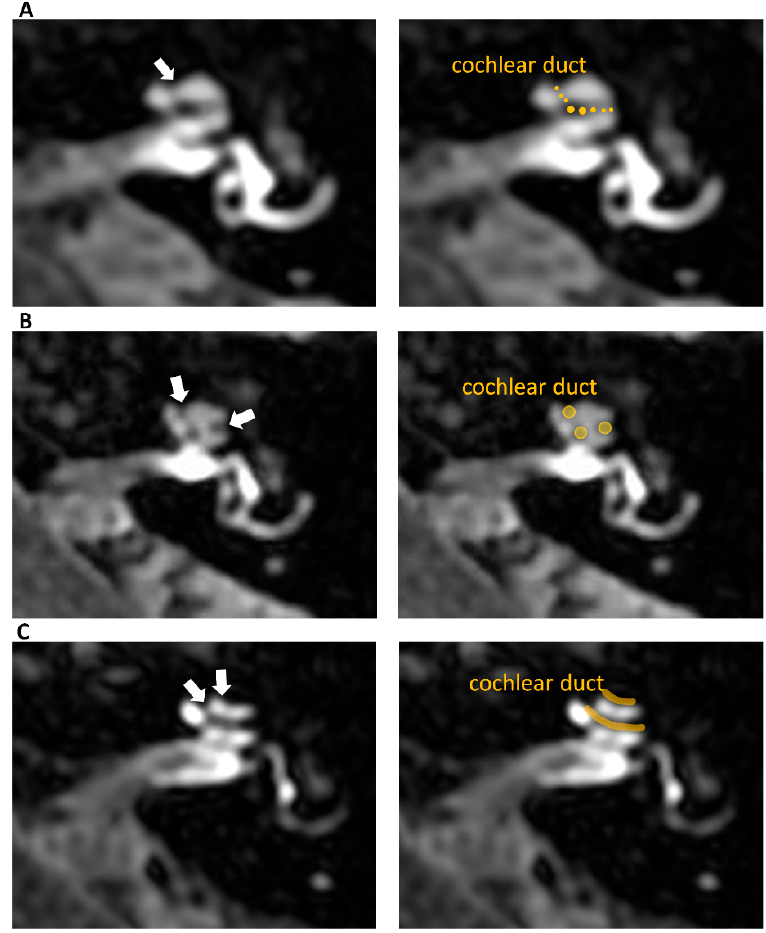
Figure 1. Delayed post-contrast 3D-FLAIR axial images of the left ears at the level of the cochlear modiolus. Right side images on panels ( A – C ) show the same images as the left ones in respective panels but in the form of companion scans with some line art applied to define specific anatomical structures for easier identification of observed pathologies. Panel ( A ) presents normal cochlea—grade 0 according to Barath classification, where a non-enhancing cochlear duct is barely visible between the enhancing scala vestibuli and scala tympani (arrow), and no signs of cochlear endolymphatic hydrops are detectable. Panel ( B ) shows grade 1 cochlear endolymphatic hydrops with partial obstruction of the scala vestibuli by a mildly dilated cochlear duct. The scan shows the nodular non-enhancing regions visible at the margins of the cochlea (arrows). Panel ( C ) presents grade 2 cochlear endolymphatic hydrops where the cochlear duct is significantly enlarged and obstructs scala vestibuli. The scan shows the non-enhancing stripes within the enhancing scala tympani (arrows). In vestibular endolymphatic hydrops in Bernaerts’ modification of the Barath scale [8],